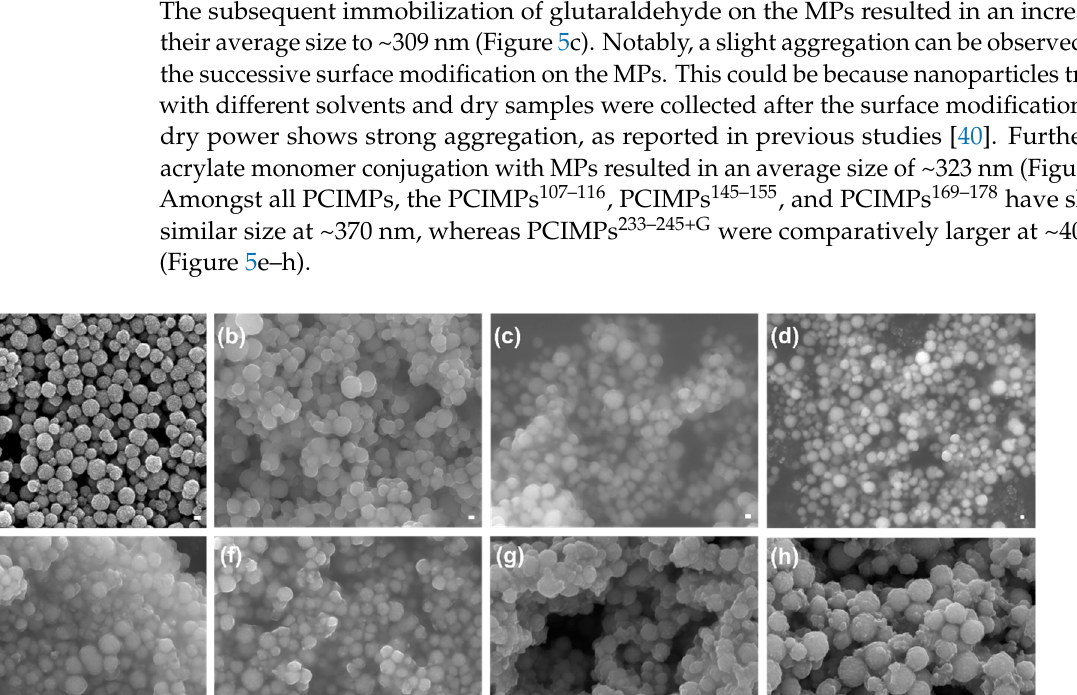
Figure 5. FE-SEM images of ( a ) Fe 3 O 4 , ( b ) Fe 3 O 4 @APTMS, ( c ) Fe 3 O 4 @APTMS-GA, ( d ) Fe 3 O 4 @APTMS-GA-acrylate, ( e ) PCIMPs 107–116 , ( f ) PCIMPs 145–155 , ( g ) PCIMPs 169–178 , and ( h ) PCIMPs 233–245+G (Scale bar: 100 nm).